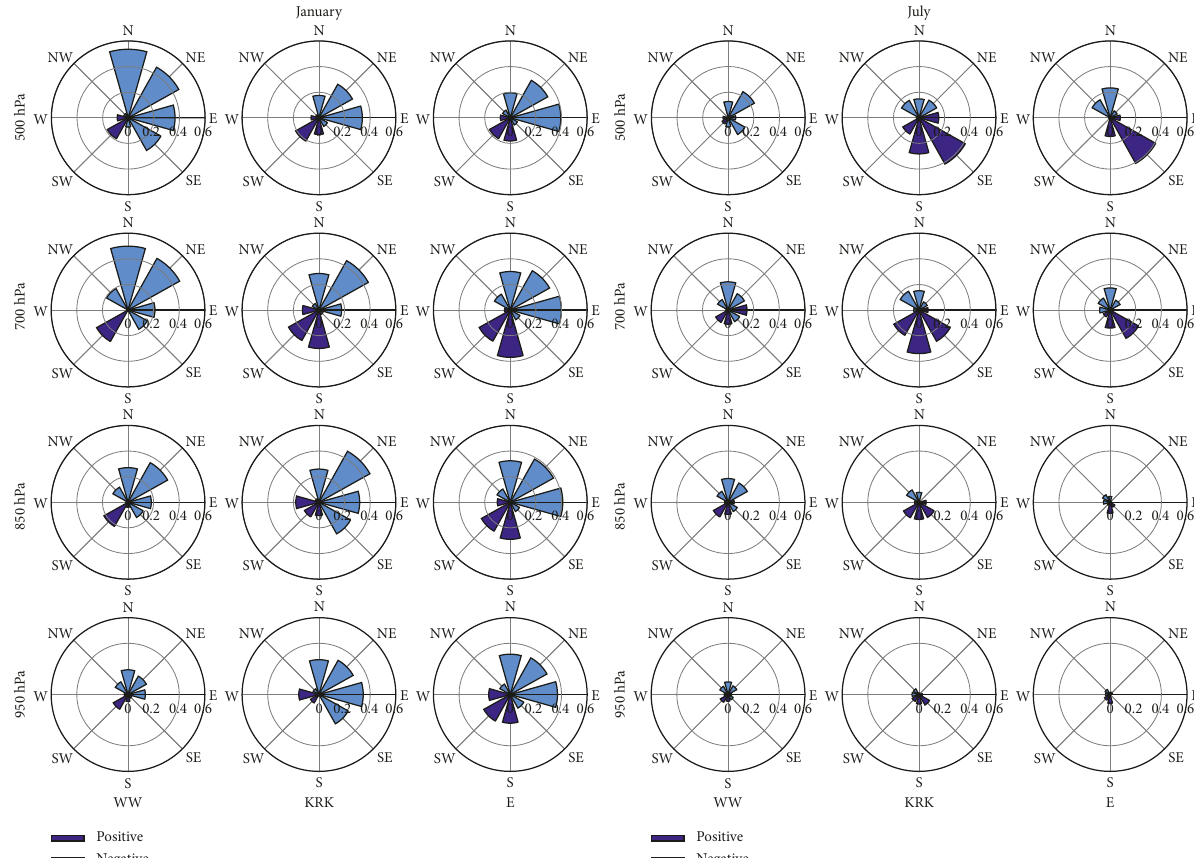
1 ) in advection directions (with respect to monthly mean, standardized) at selected pressure kg · −